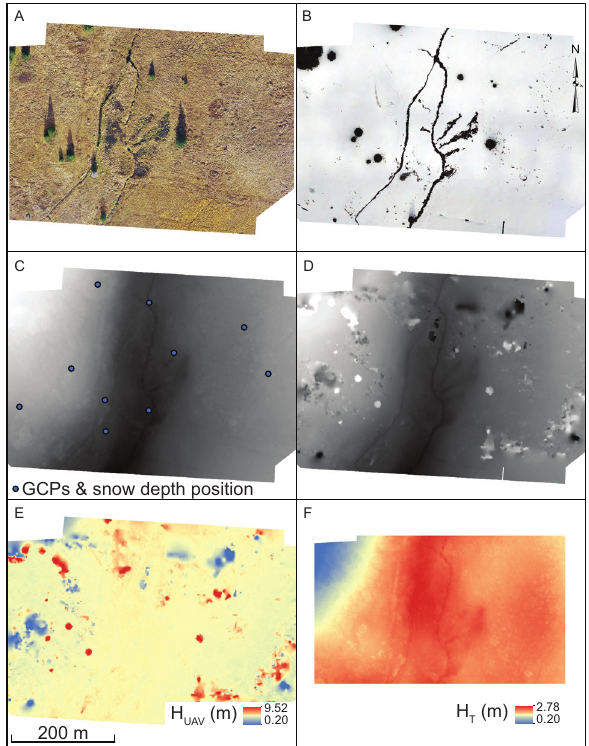
Figure 2. (a,b) Orthophotos of the open area before and after snowfall. (c,d) Digital elevation models (DEMs) before and after snowfall, GCPs and positions of manual snow depth probes in c. (e) Map of the differences between UAV-based DEMs. (f) Map of the interpolated snow depth values of manual snow probes. The RMSE varies between 22 cm and 42 cm between both sites. However, the amount of data that have been used is very small, and snow depths at manually taken probe positions vary between 0.20 m and 0.38 m for open area and between 0.20 m and 1.05 m for dead forest (Table 3, 4).